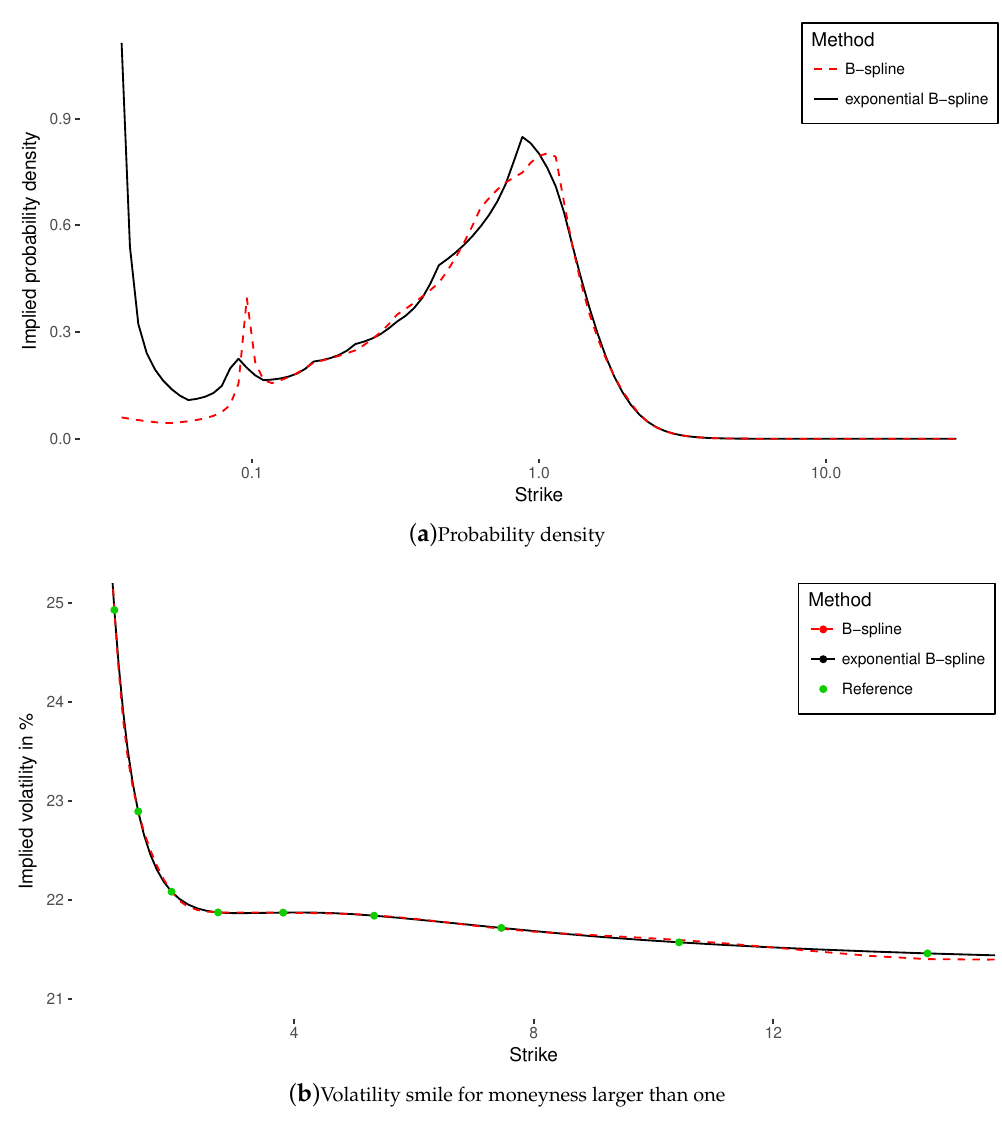
Figure 5. Implied probability density and implied volatility for the spline collocations of the market data of Table A2 in appendix A. Table 4. Root mean square error (RMSE) of the collocation method implied volatilities starting the calibration with the Bachelier, the convex, or the “best” initial guess, and using a small regularization